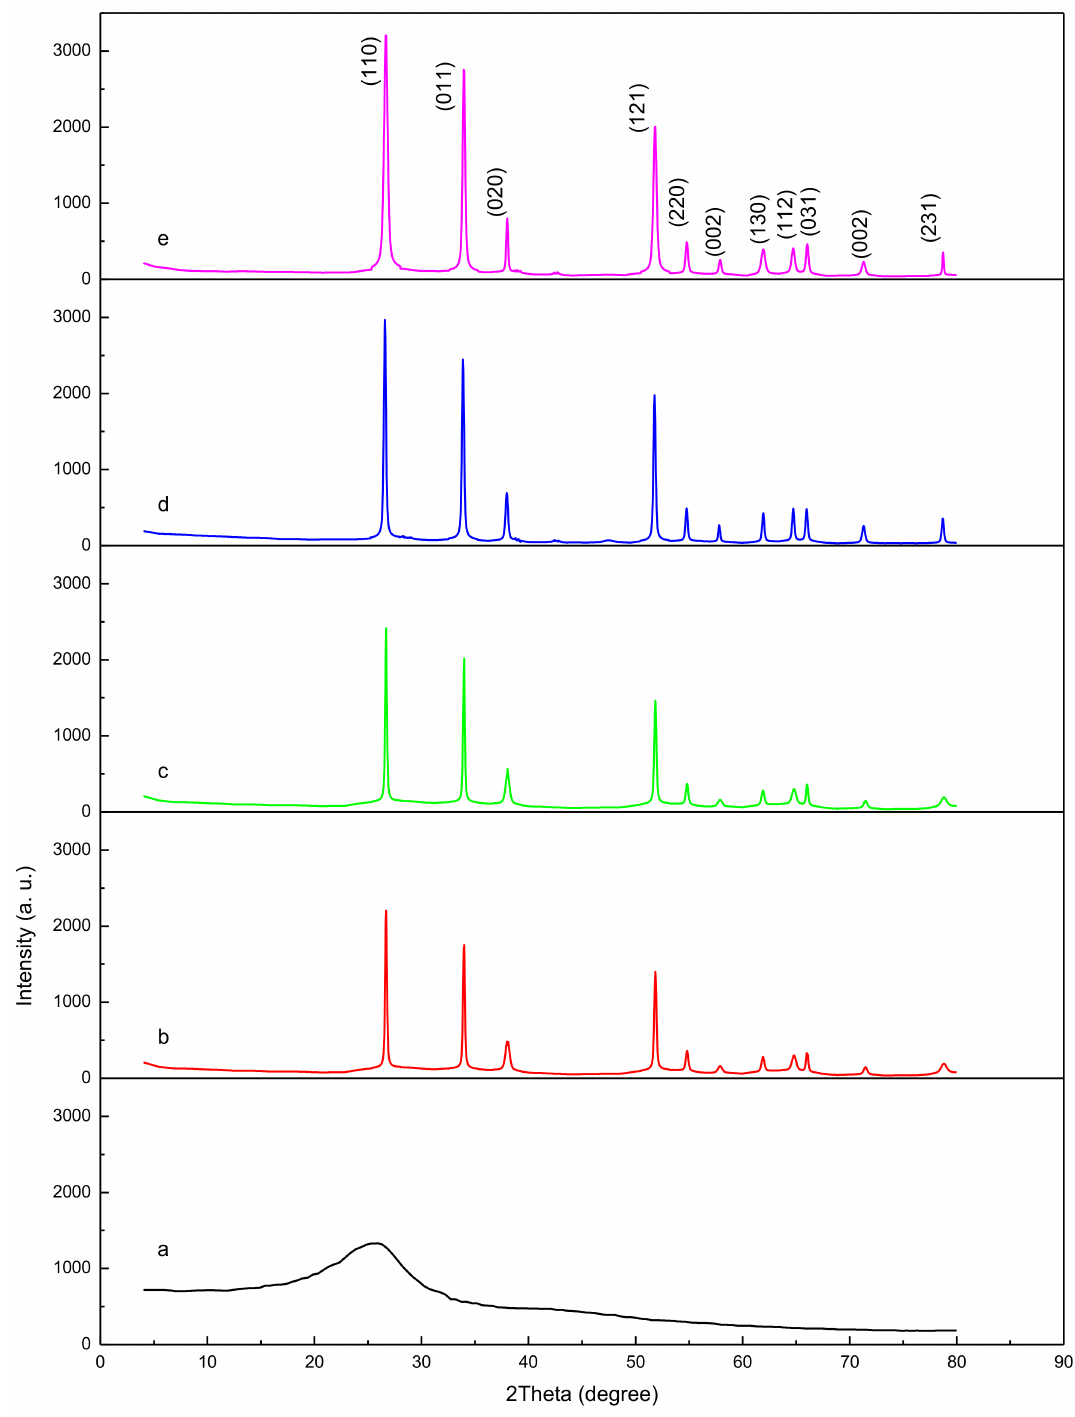
Figure 2. Nanoparticle XRD patterns prepared at 30 ◦ C/room temperature ( a ). with calcination at 500 ◦ C ( b ), 600 ◦ C ( c ), 700 ◦ C ( d ), and 800 ◦ C ( e